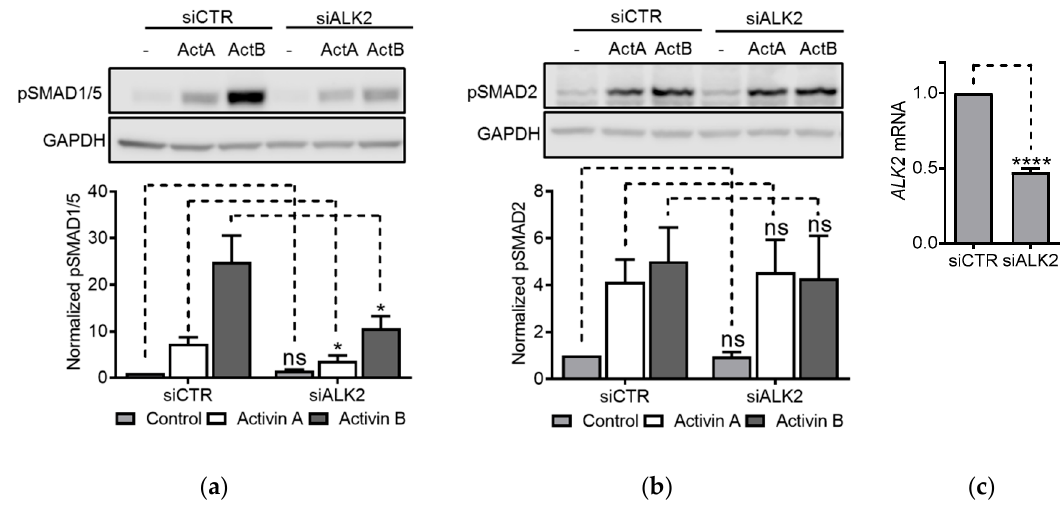
Figure 5. ALK2 knockdown blunted activin-induced SMAD1/5 activity. INA-6 myeloma cells were transfected with siRNA targeting ALK2 or Non-Targeting Pool as a control. The cells were treated 2 days post transfection with activin A (50 ng/mL) or activin B (10 ng/mL) for 2 h. Then, the phosphorylation status of SMAD1/5 ( a ) and SMAD2 ( b ) was measured by western blot. Representative experiments are shown (upper panels) and relative activation was calculated based on signal intensities of the SMADs and GAPDH for normalization (lower panels). The graphs represent mean ± s.e.m. of n = 3 independent experiments. Two-way ANOVA and Bonferroni’s multiple comparisons test were performed (* P ≤ 0.05, ns (not significant) P > 0.05). ( c ) ALK2 mRNA levels were measured by PCR using the comparative Ct method and GAPDH as housekeeping gene. The graph represents mean ± s.e.m. of three independent experiments. A two-tailed, paired t -test was performed (**** P ≤ 0.0001).